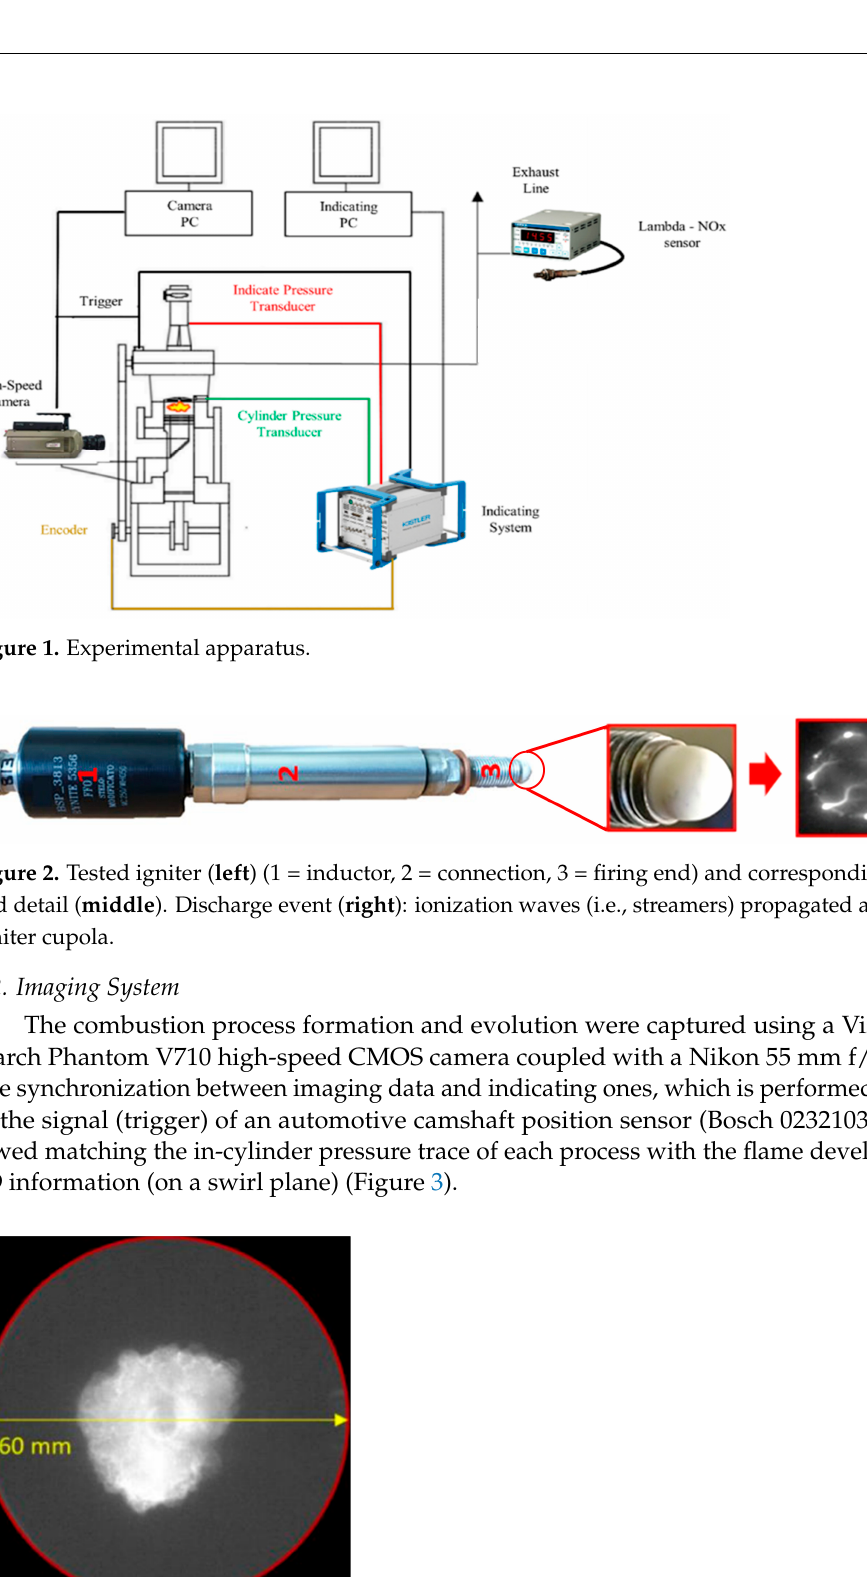
Figure 3. Detection of the fl ame front evolution.